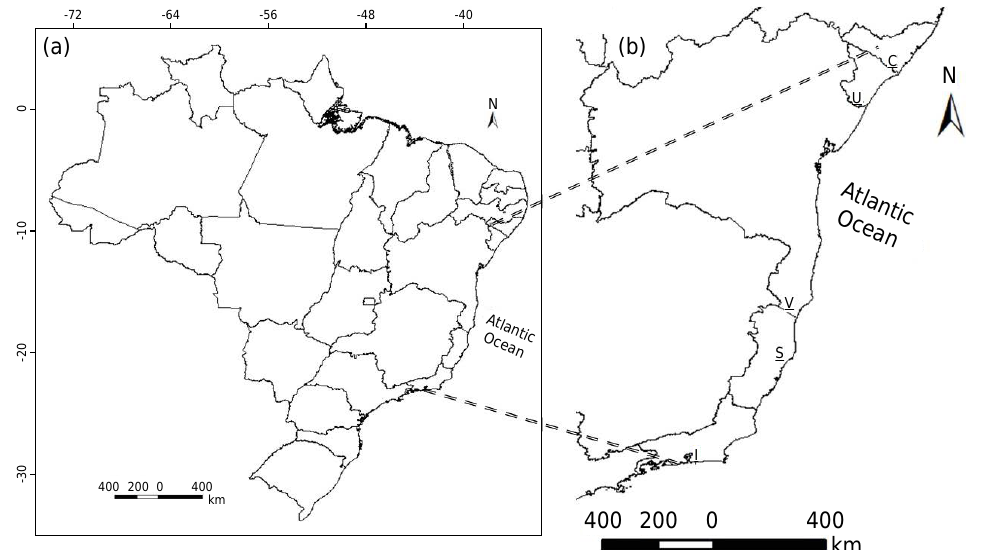
Figure 1. Map of Brazil with the states boundaries (a); in the map are highlighted the location of the study areas: C - Coruripe (Alagoas State); U - Umbaúba (Sergipe State); V - Nova Viçosa (Bahia State); S - Sooretama (Espírito Santo State); and I - Itaboraí (Rio de Janeiro State) (b).